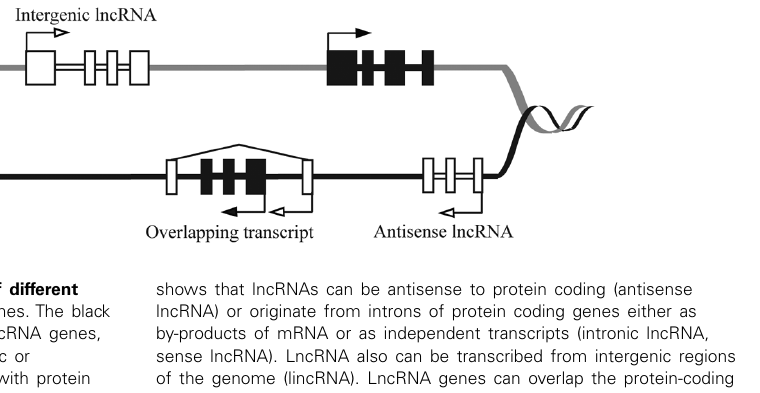
FIGURE 1 | Schematic showing genomic organization of different lncRNAs. The DNA strands are shown in black and gray lines. The black and white boxes represent exons of protein coding and lncRNA genes, respectively. LncRNAs are classified as sense (e.g., Intronic or overlapping) or antisense, reflecting the way they overlap with protein coding genes in the same or opposite direction, respectively. The diagram